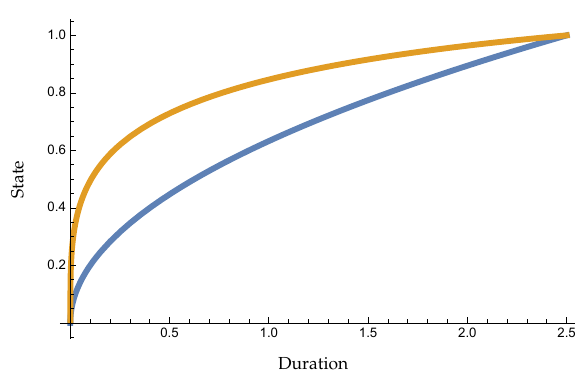
Figure 14. Strategy OPT (Blue) and online strategies for t = 0.312, z = 0.2 (Brown).